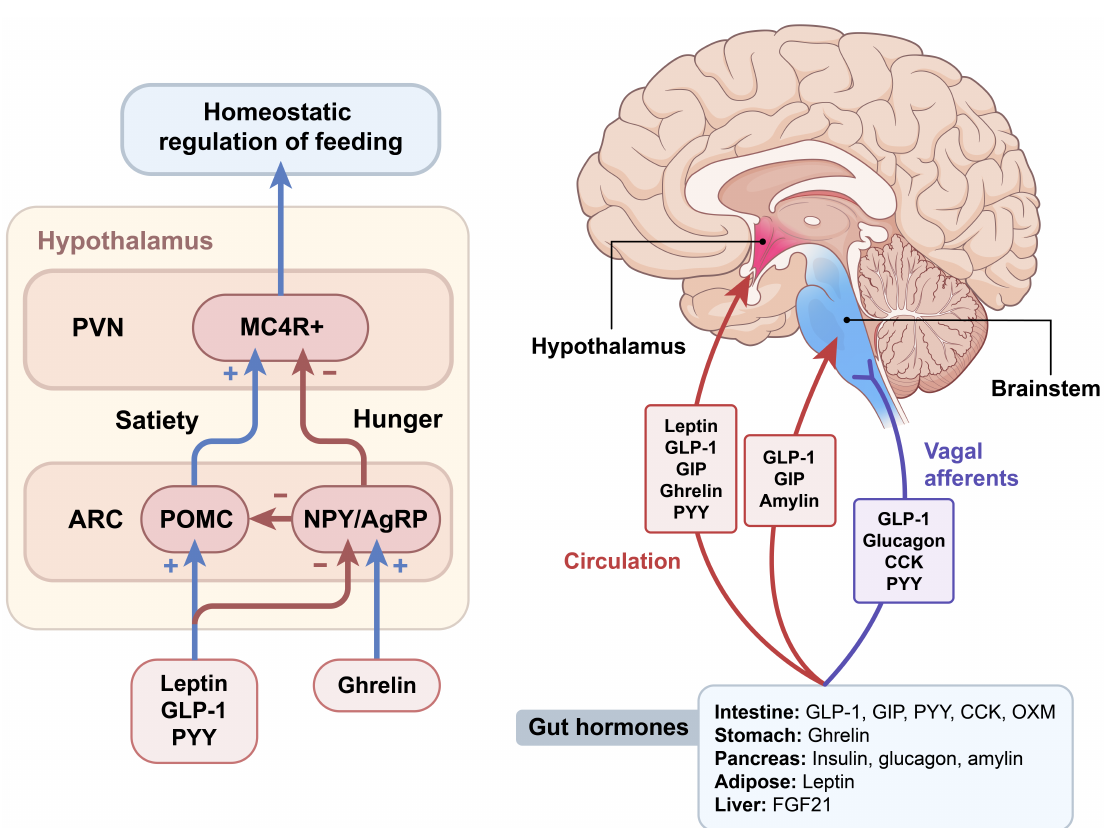
Figure 1. Gut–brain regulation of food intake. Various peripheral hormones, including gut hormones, Figure 1. Figure 1. regulate food intake by acting on integrated neural circuits in the hypothalamus and brainstem. The hypothalamic melanocortin system is a central hub for the regulation of homeostatic food intake, including appetite-inducing neurons that co-express neuropeptide Y (NPY) and agouti-related peptides (AgRP), and anorexic neurons that express pro-opiomelanocortin (POMC). Gut–brain communication is mediated through vagus nerve afferents that project to the nucleus tractus solitarius in the hindbrain, or via the circulation reaching the median eminence of the hypothalamus and area postrema of the brainstem. ARC, arcuate nucleus; CCK, cholecystokinin; FGF21, fibroblast growth factor 21; GIP, glucose-dependent insulinotropic polypeptide; GLP-1, glucagon-like peptide-1; MC4R, melanocortin 4 receptor; OXM, oxyntomodulin; PVN, paraventricular nucleus; PYY, peptide tyrosine